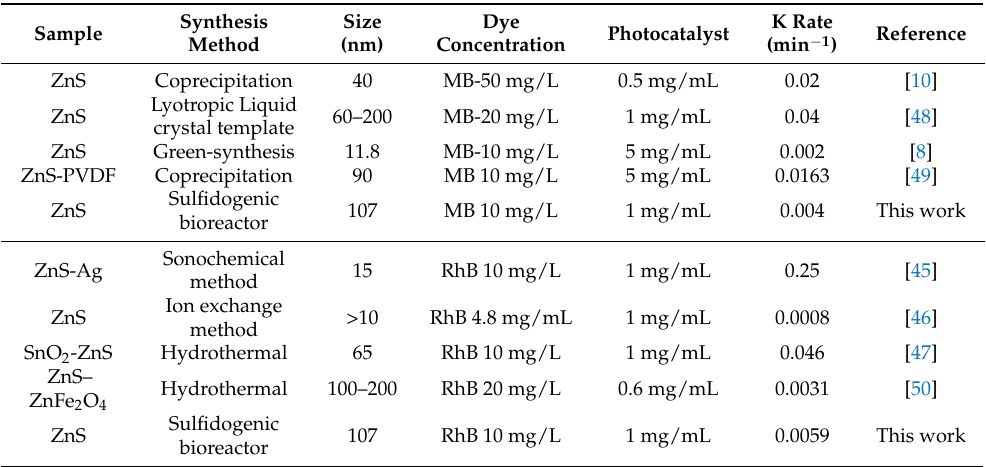
Table 1. Previously reported results of photocatalytic activity of ZnS nanostructures.